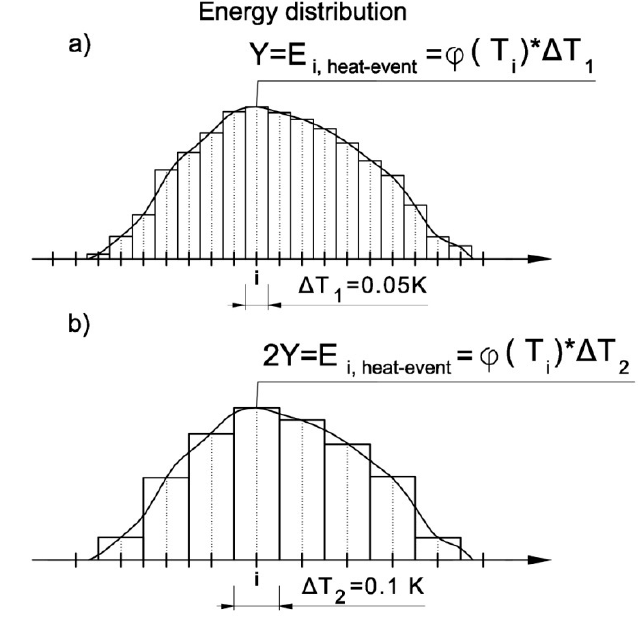
Figure 6. Influence of temperature interval widths on energy value, (a) 0.05K wide interval, (b) 0.1K wide interval .